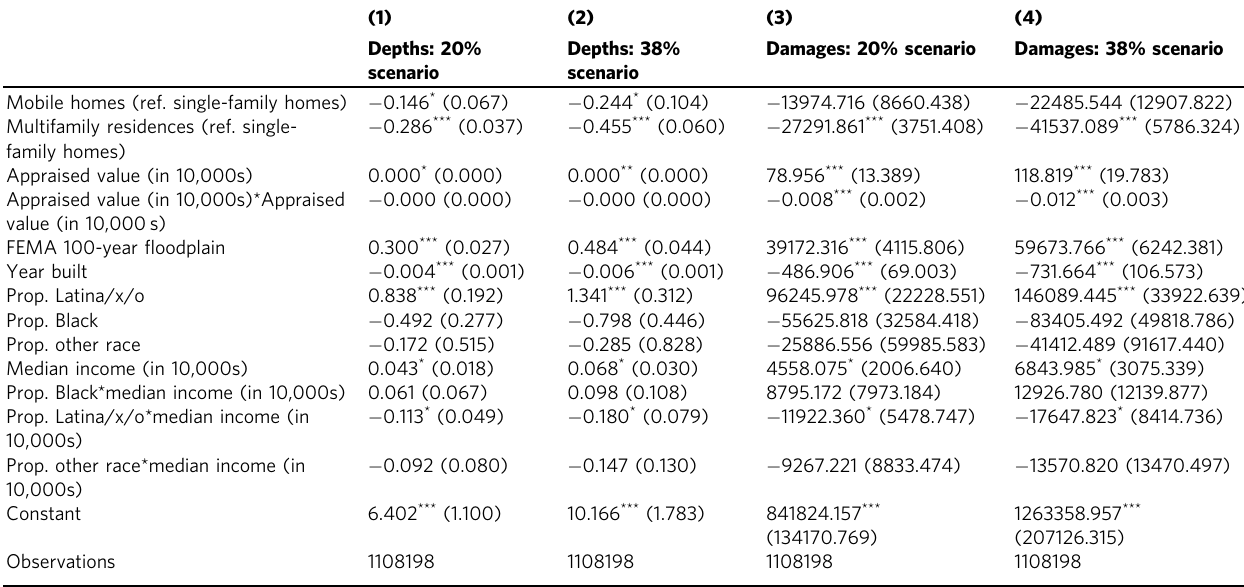
Table 1 Tobit regression of climate change-attributed depths for Hurricane Harvey in Harris County, Texas.